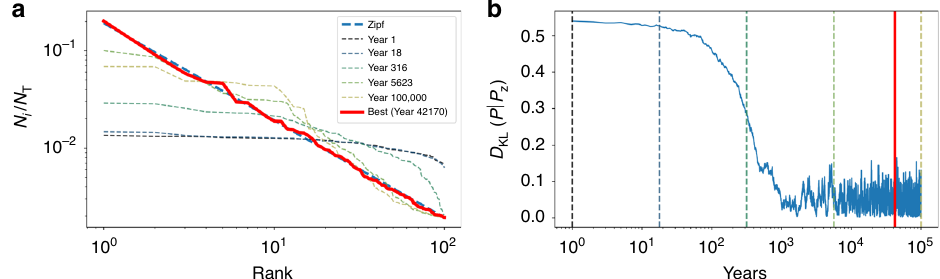
Fig. 3 Stochastic migration rates restore the symmetry of city growth rates over time, leading to Zipf ’ s law. The fi gures show the temporal solution of the demographic dynamics (Eq. (13)) when rotational symmetry is restored through stochasticity averaged over long times. a Shows the population structure at different times (dashed lines) and the distribution with smallest divergence from Zipf ’ s law over a long run (red), measured by the smallest observed D KL ( P ∣ P z ). b shows the trajectory of the Kullback-Leibler divergence away from Zipf ’ s law over time. After a long time period, the population structure approximates Zipf ’ s law and fl uctuates around it. In this regime, at any single time only samples showing some deviations from Zipf ’ s distribution are observable: it is only on the average over many structure vectors at long times that Zipf ’ s law emerges as a good characterization of the city size distribution. Fig. 4 shows that this was indeed the case for the US urban system until